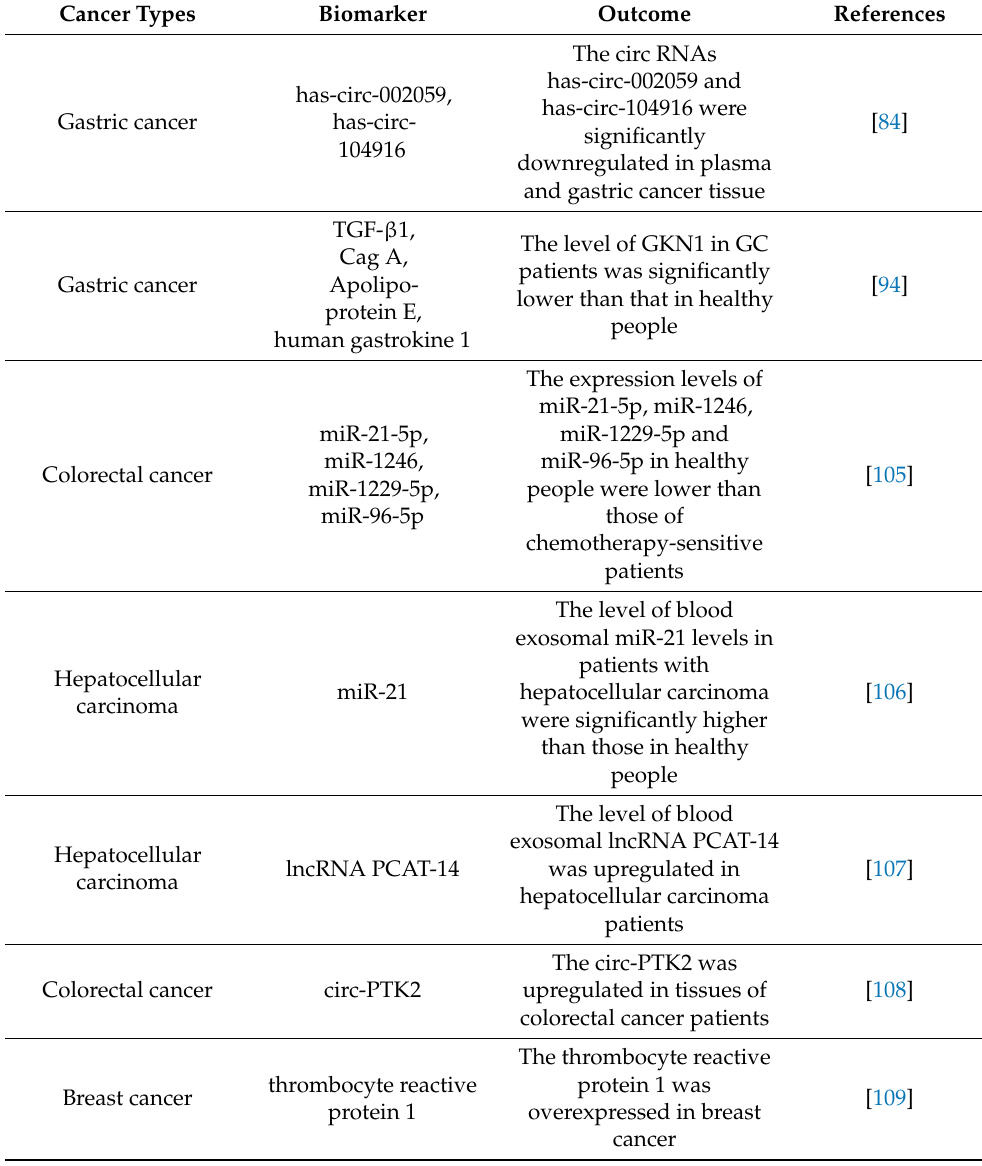
Table 3. The applications of exosomes as